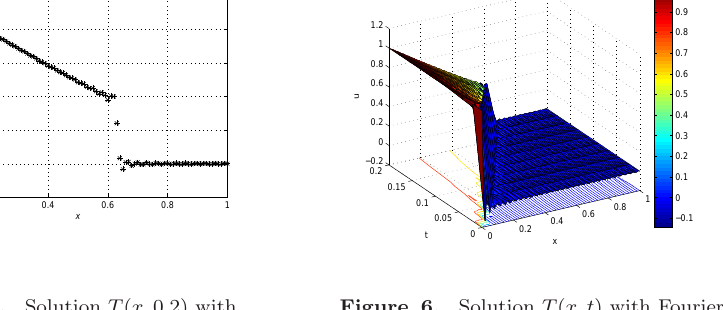
Figure 5. Solution T ( x, 0 . 2) with Fourier method, N = 80.